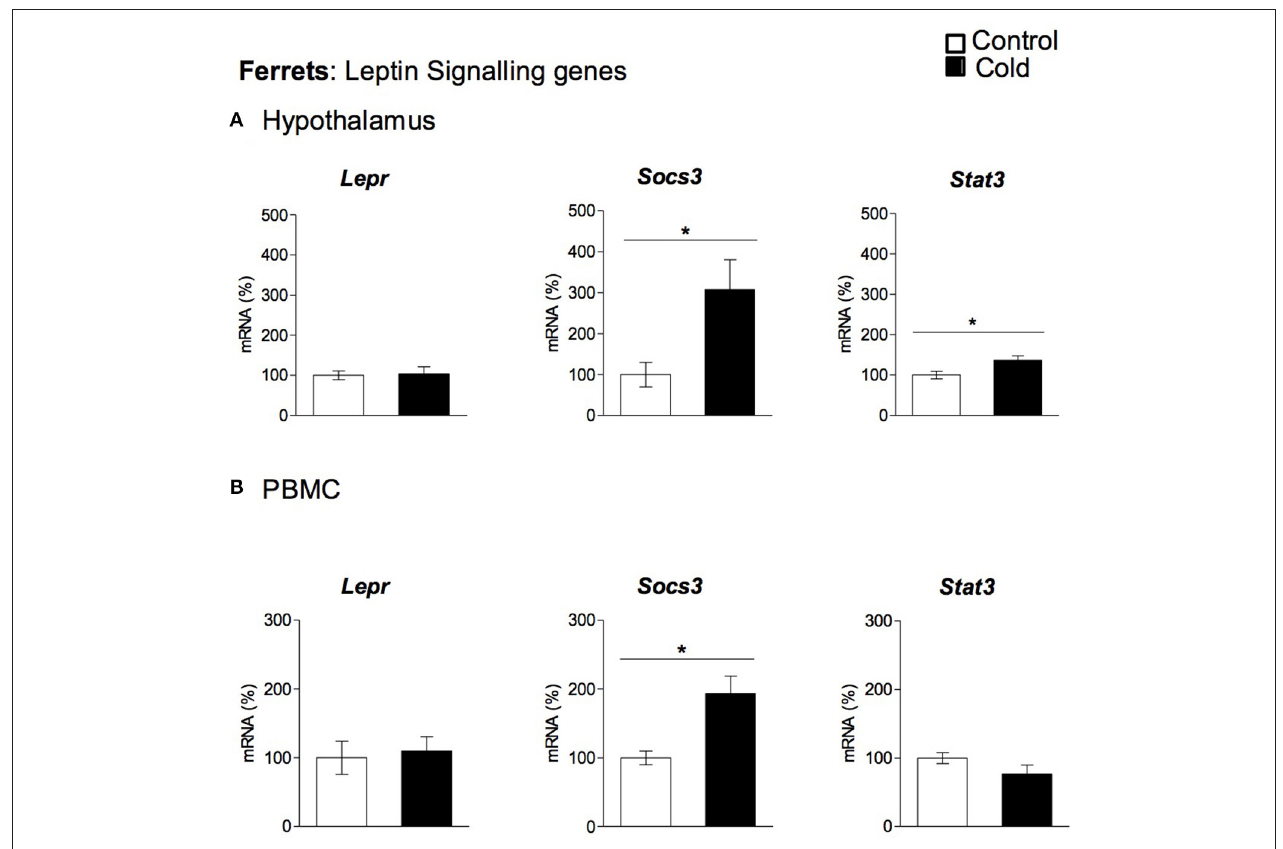
FIGURE 4 | Gene expression of leptin signaling related genes ( Lepr , Socs3 and Stat3 ) measured by qRT-PCR in (A) hypothalamus and (B) PBMC of adult ferrets acclimatized to different room temperatures: 22 ◦ C (control) or 4 ◦ C for 1 week (cold). Results represent mean ± SEM ( n = 5–7) of ratios of specific mRNA levels relative to Rgp1 for hypothalamus, and Mettl2a for PBMC , expressed as a percentage of the value of fed animals in the Control group that was set to 100%. *Effect of cold exposure (cold-exposed rats vs. their respective controls; Student’s t -test, p < 0.05, or indicated when